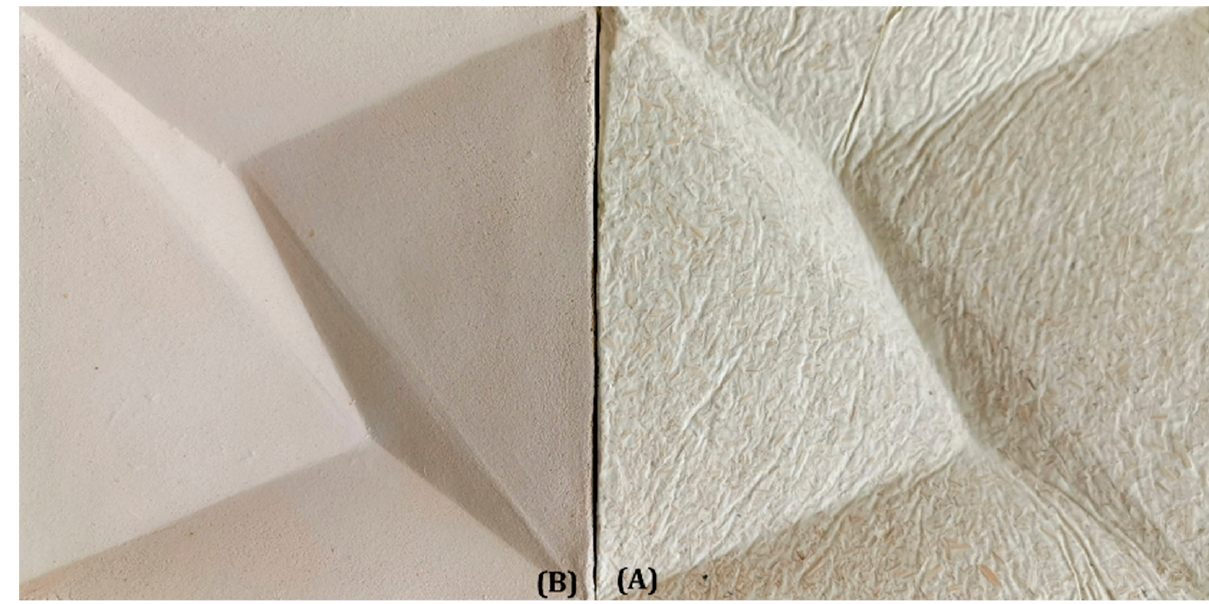
Figure 4 shows a comparison of the surface structures of both the described materials.